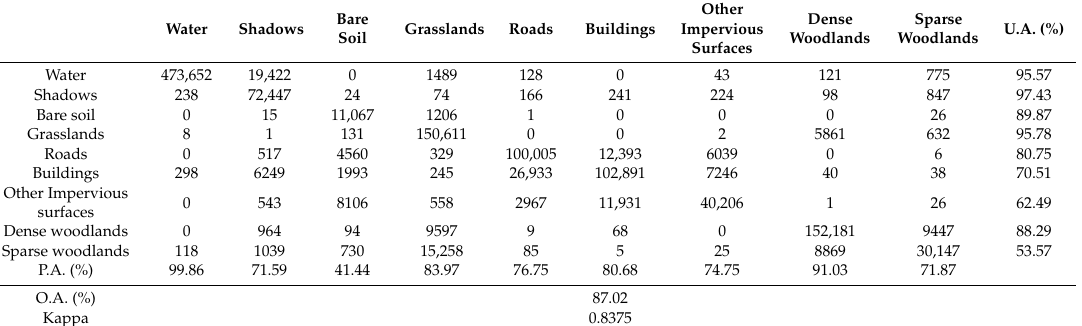
Figure 10. The final class types. Table 4. Confusion matrix and accuracy of the final